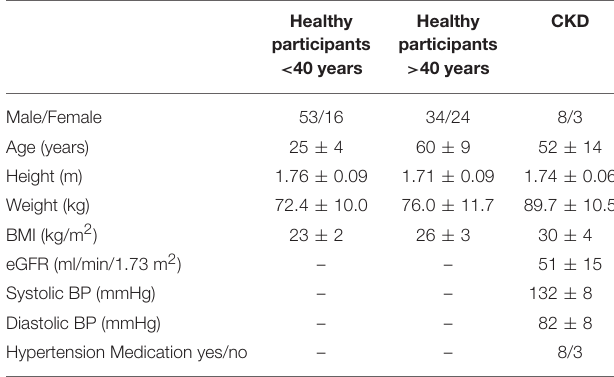
TABLE 4 | Characteristics of healthy participants, split according to age, < 40 years and > 40 years, and the chronic kidney disease patient cohort. Healthy participants < 40